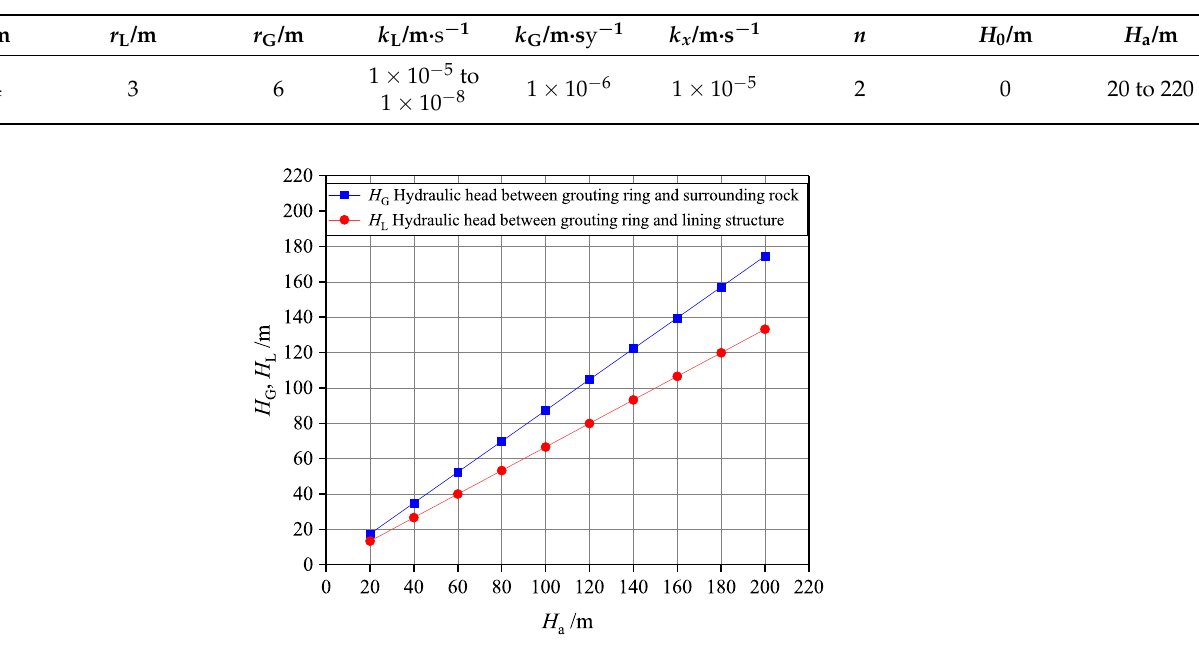
Figure 6. Total hydraulic head along coordinate axis. ( a ) n = 2. ( b ) n = 3. Table 2. Calculation parameters in parameter analysis.